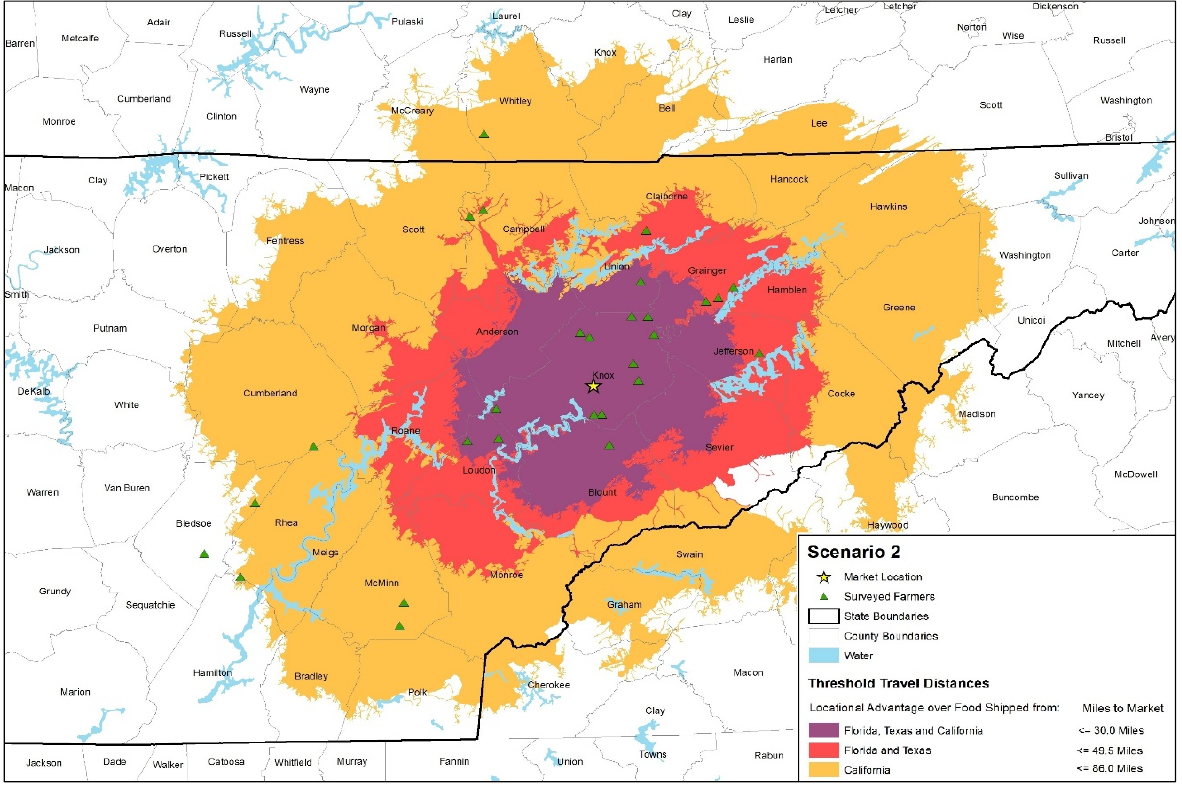
Figure 5. Scenario 2 Competitive Transportation Zones Scenario 2 models the average, scaled-up local farmer who plants 6 acres (2.4 ha) in fruits and vegetables and employs a box truck for transportation (see Table 3 for scenario